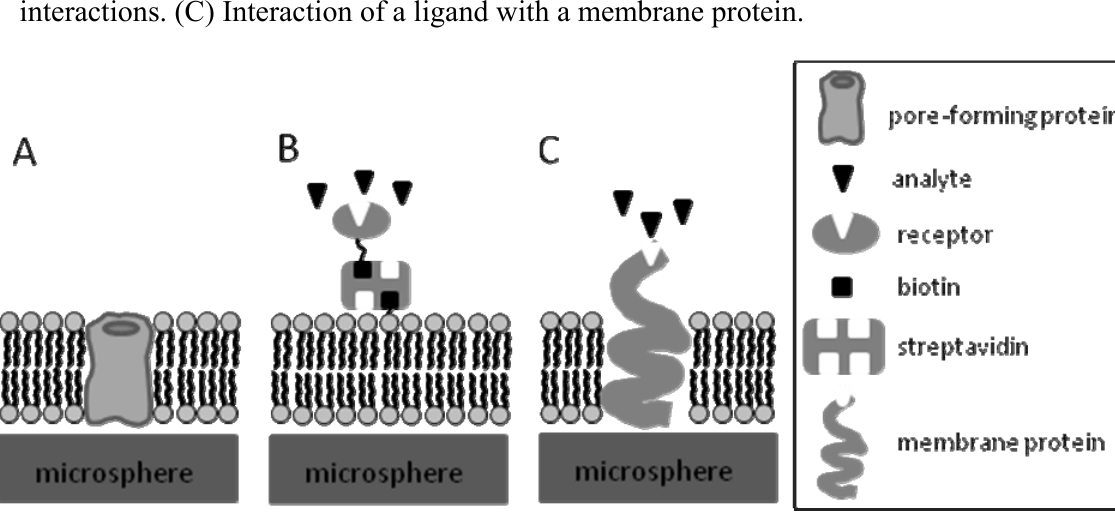
Figure 6. Schematic showing examples of interactions of biomolecules with SLBs. (A) Interaction with SLB by incorporating a pore-forming protein into the SLB. (B) Interaction of a ligand with a biomolecule tethered onto the SLB through biotin-streptavidin interactions. (C) Interaction of a ligand with a membrane